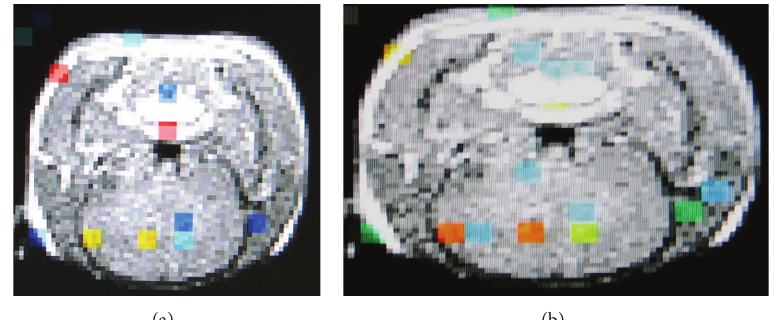
Figure 1: (a) Activation of the ACC, PFC, and THAL in the brain of an IBS model rat. (b) Increased activation of the ACC, PFC, and THAL with 10 mL air inflation in the balloon in the same rat.